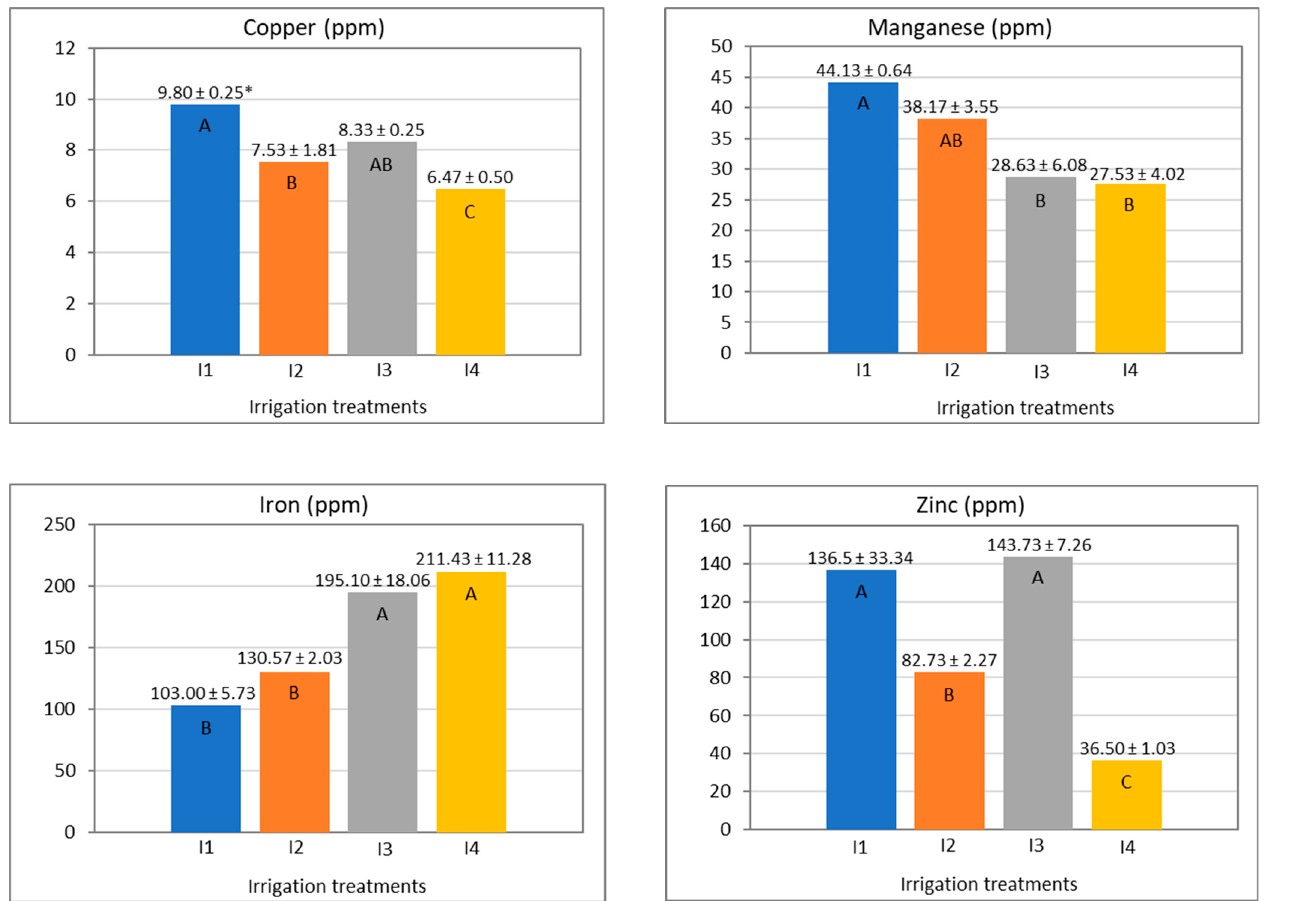
Figure 3. Concentrations of Cu, Mn, Fe and Zn in tomato leaves cultivated under different irrigation conditions; * mean ± standard deviation; data in bars with the same letters are not significantly different at p > 0.05 according to Tukey’s